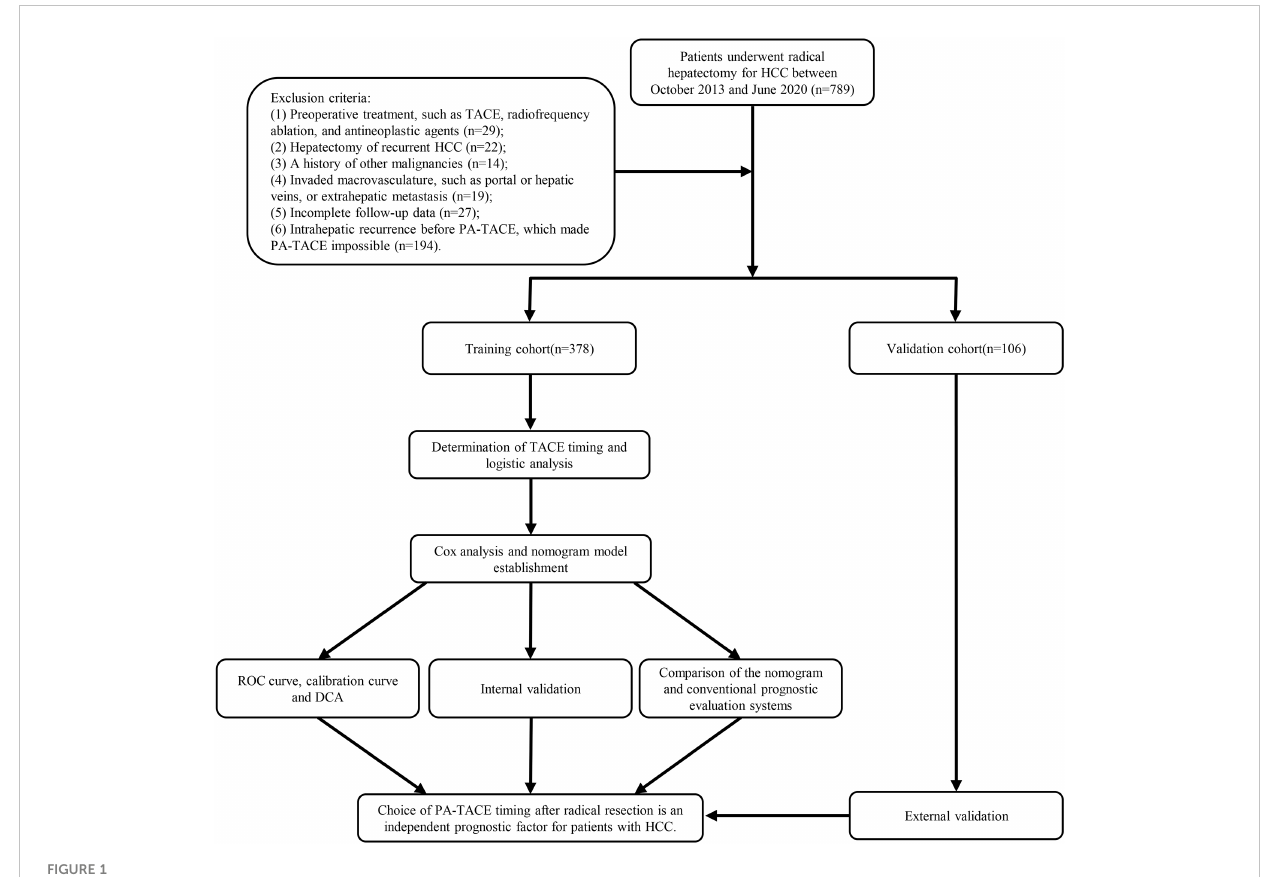
FIGURE 1 The fl ow chart of the study